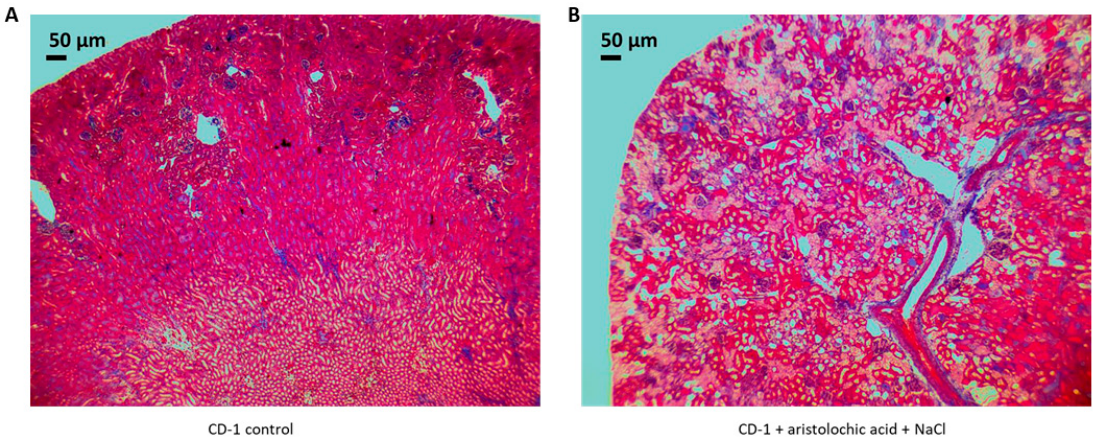
Figure 5. Aristolochic acid + NaCl-induced kidney disease in mice. Representative photomicrograph (4X) of Masson’s Trichrome-stained kidneys from a control CD-1 mouse ( A ) and an aristolochic acid + NaCl-administered CD-1 mouse ( B ). Renal interstitial scarring is clearly evident in the latter.